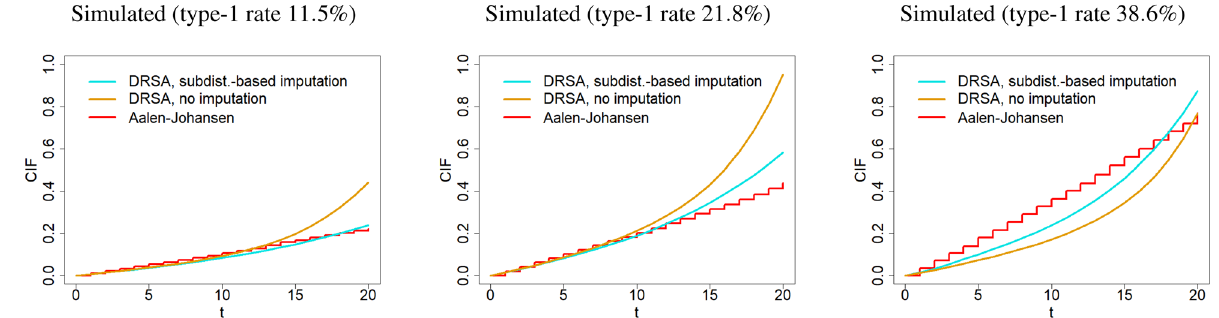
Figure 4. Calibration plots obtained from the simulated test data in Table 1 using the DRSA architecture. Each plot presents the averaged type-1 cumulative incidence functions as obtained from (i) training the DRSA network with the preprocessed training data (cyan) and (ii) training DRSA treating individuals with observed competing events as censored (orange). Red curves refer to the nonparametric Aalen-Johansen reference curves.